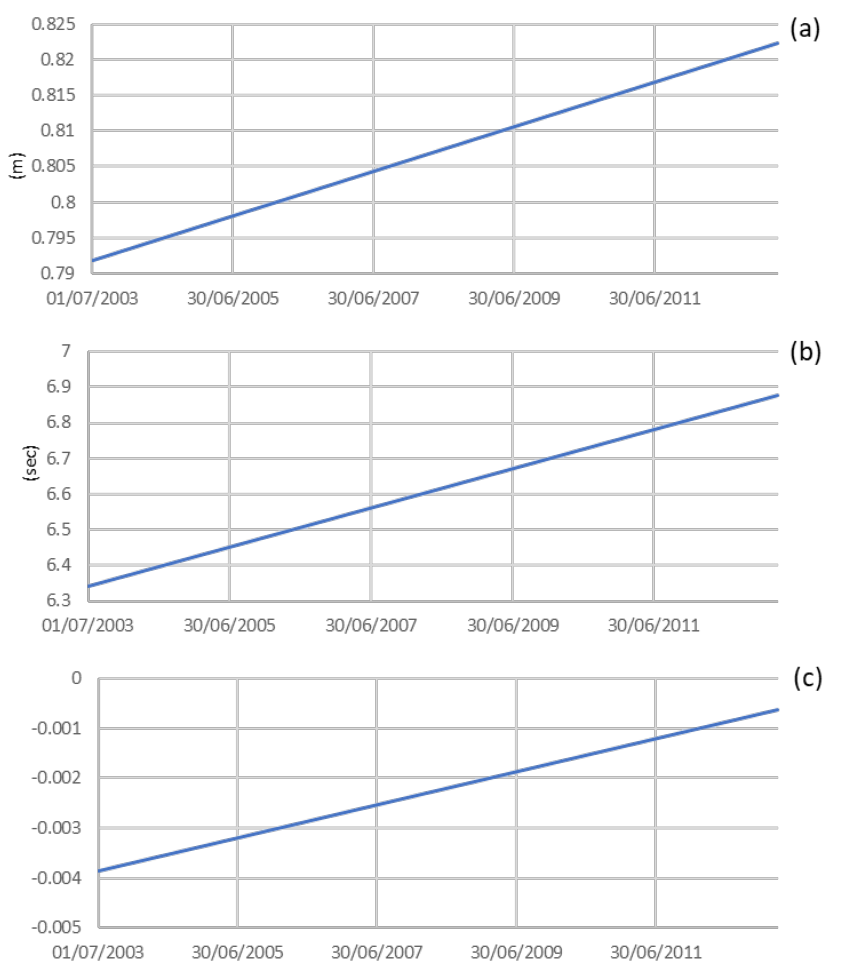
Figure 5. For 1 July 2003 to 31 March 2013, the upper panel ( a ) shows the significant wave height trend ( H s ), similarly, the middle panel ( b ) depicts the peak wave period trend, and finally, the lower panel, ( c ), shows the wave direction trend. Dates are shown in day, month, year format.